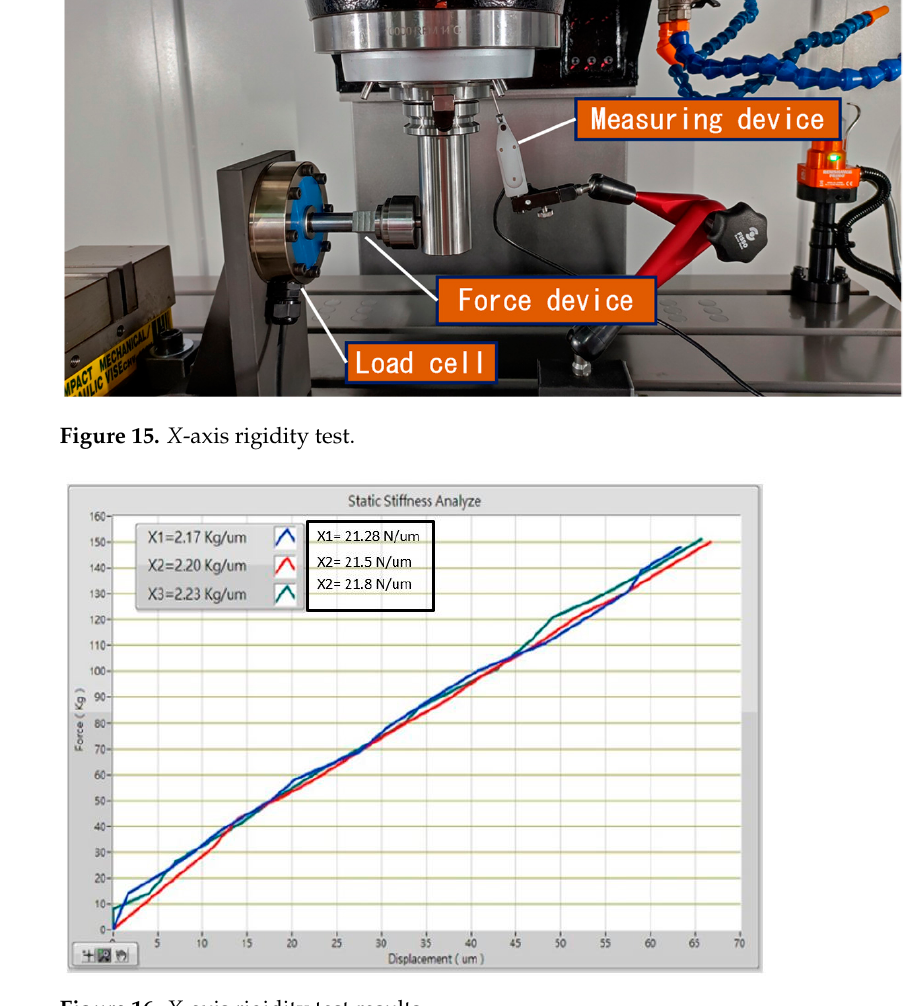
Figure 16. X -axis rigidity test results.